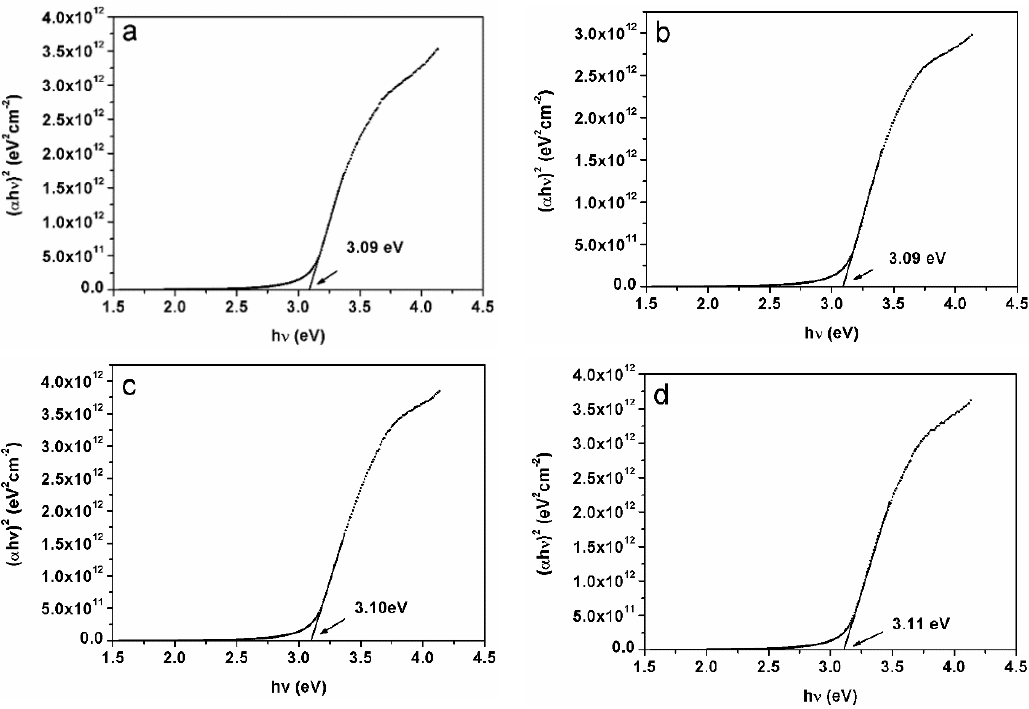
Figure 7. Direct band gaps of the CuCr 1 − x Zn x O 2 films for x = ( a ) 0, ( b ) 0.025, ( c ) 0.065, and ( d ) 0.085.